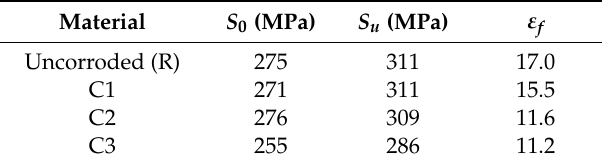
Figure 6. Tensile curves of the uncorroded and corroded samples. Table 2. Yield stress, tensile strength, and elongation values obtained from Figure 6.